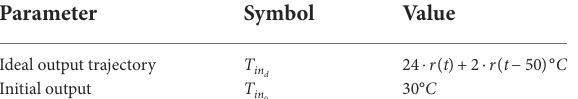
FIGURE 5 Tracking performance with NN compensation.